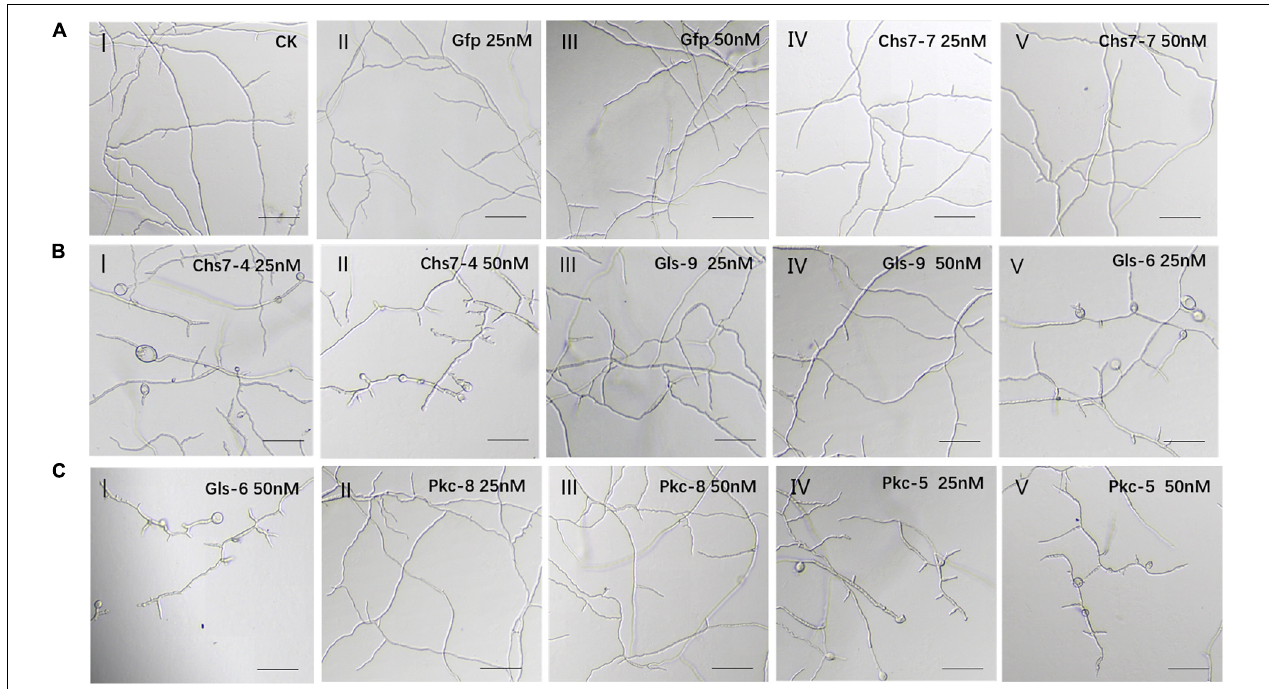
FIGURE 3 | (A-C) Inhibition and morphology of Fusarium graminearum (Fg) cultured in SNA medium containing dsRNAs. Mycelia at 16 h of incubation with different concentrations of dsRNAs were made. One hundred Fg macroconidia were suspended in 100 µ l of liquid SNA medium containing different concentrations of dsRNAs. SNA omitting dsRNAs and Gfp-dsRNAs was used as a negative